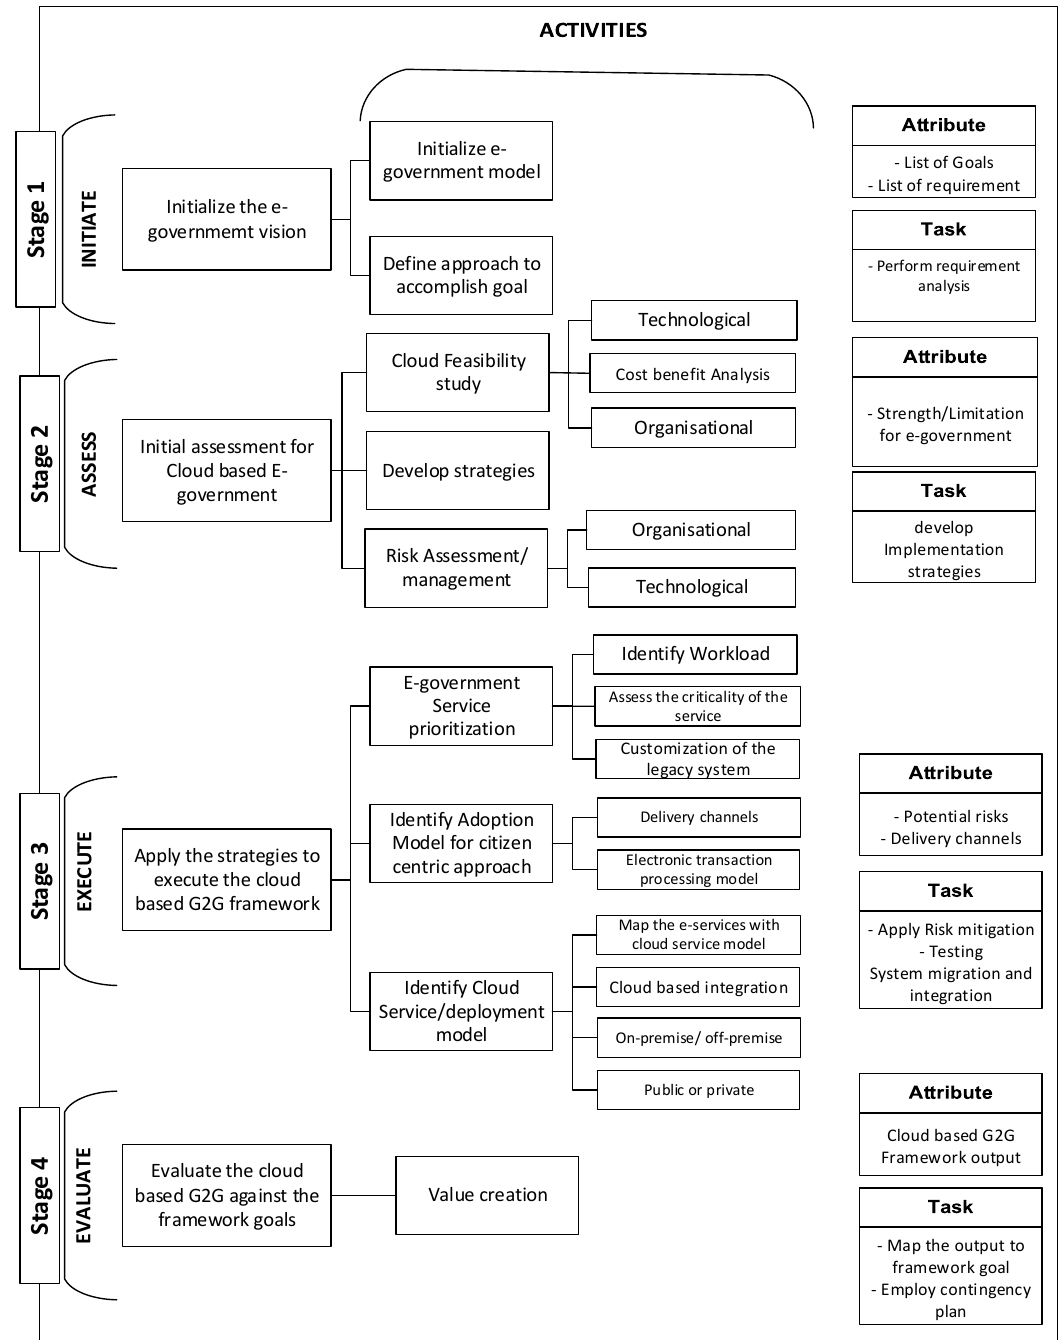
Figure 2. Cloud-based G2G e-government framework stages and assimilation process.